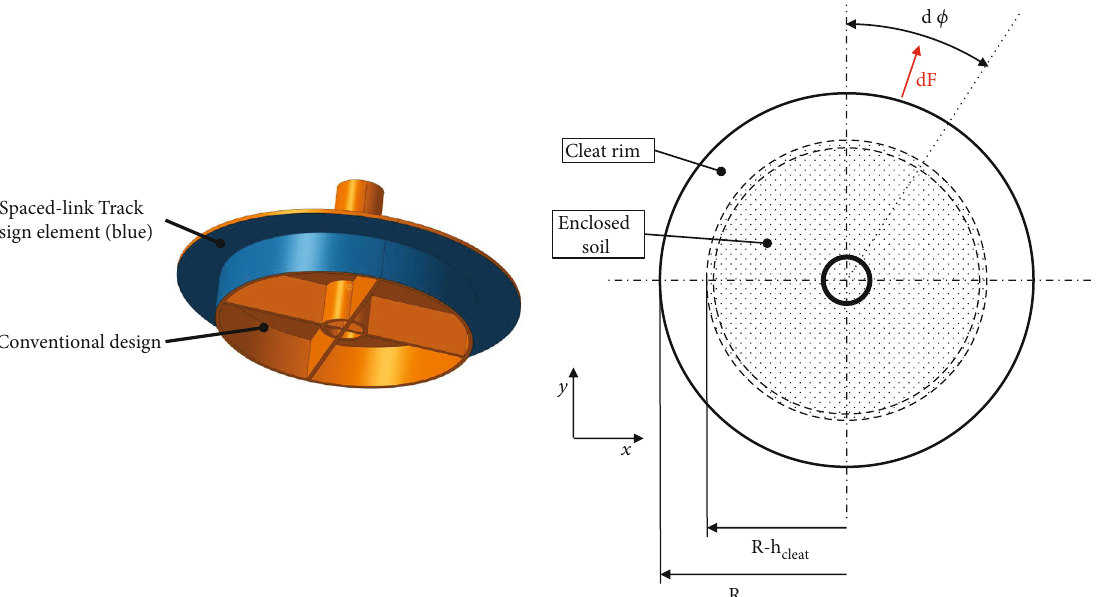
Figure 9: Schematic top view of the new proposed